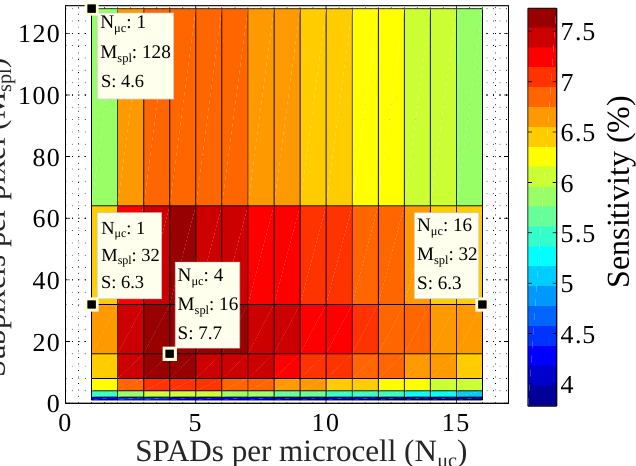
Figure 7. Calculated maximum sensitivity as a function of M spl and N µ c , for a 1mm 2 pixel. The val- ues were obtained from Equation (10), Table 1, and Figure 6. The number of subpixels is a power of 2 in order to maximize the symmetry in the TDC trigger